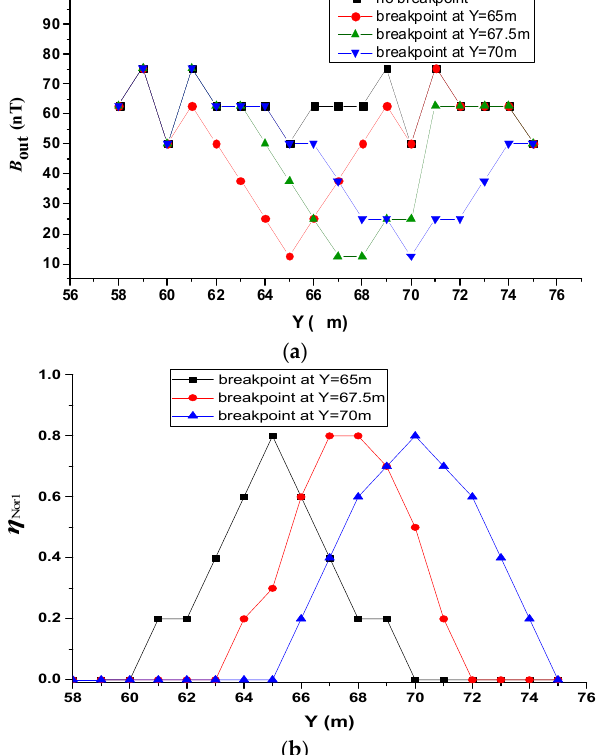
Figure 10. Simulations of one breakpoint occurring at different locations. ( a ) Secondary field along the survey line above the #6 conductor. ( b ) Secondary field changes normalized to the case without one breakpoints.